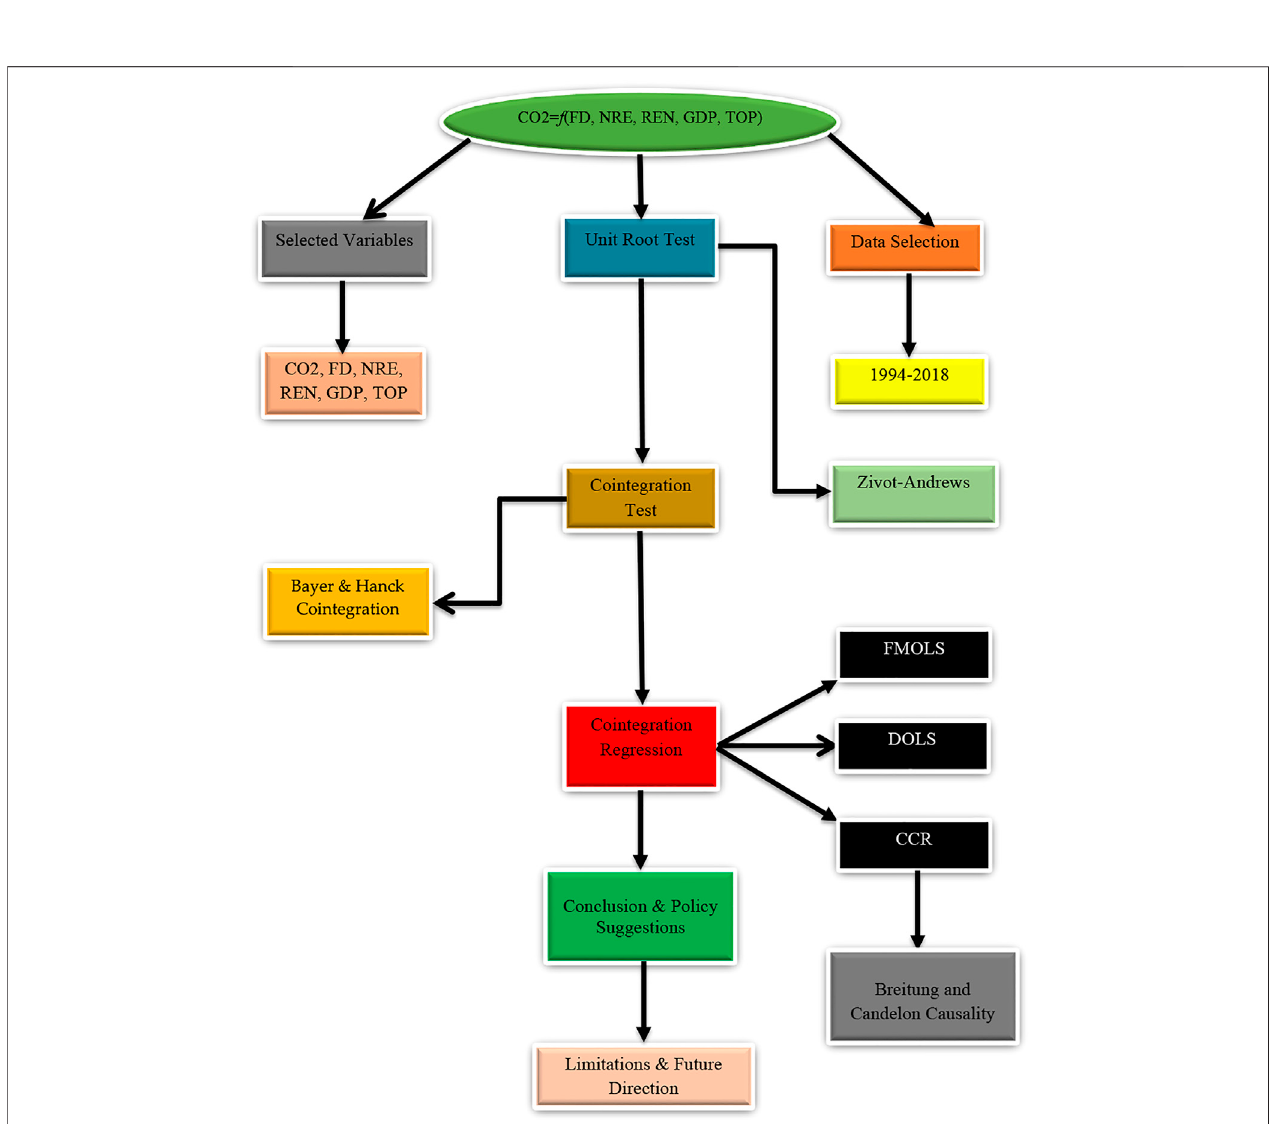
FIGURE 1 | Flow chart of the